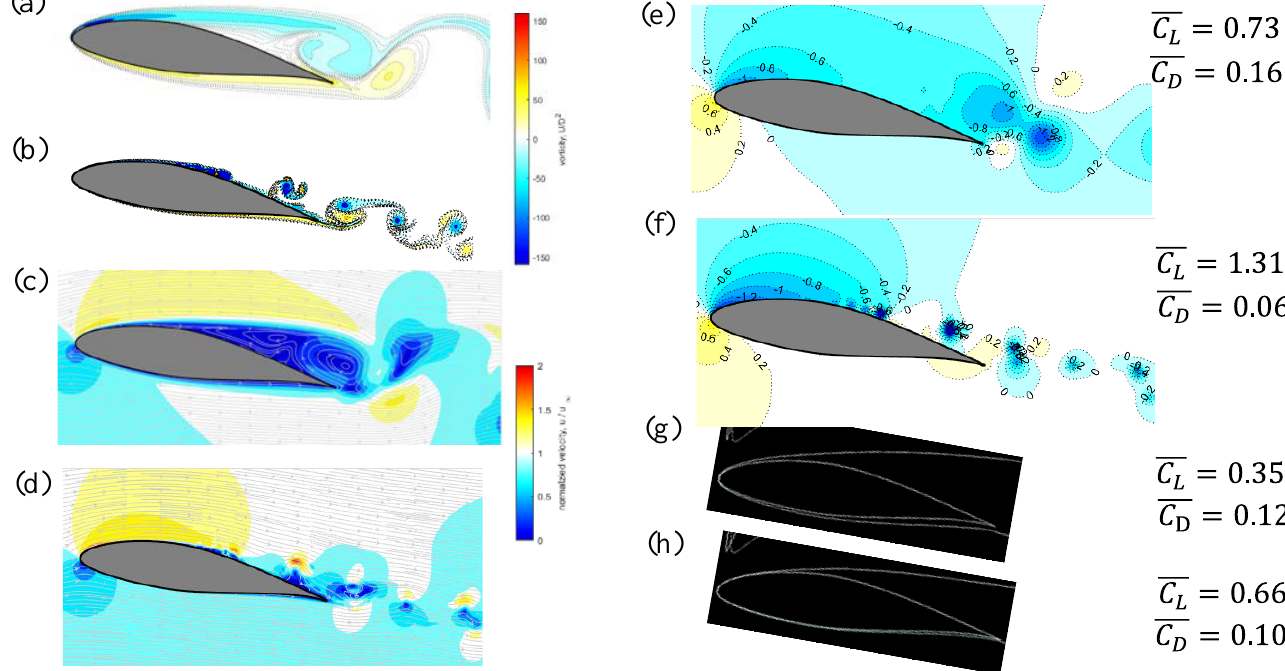
Figure 8. Instantaneous fields of NACA64 airfoil at α = 10 ◦ . Vorticity: ( a ) Re C = 4000 and ( b ) Re C = 60,000. Velocity: ( c ) Re C = 4000 and ( d ) Re C = 60,000. Pressure coefficients, Cp: ( e ) Re C = 4000 and ( f ) Re C = 60,000. Steady-state simulation of boundary layer streamlines by XFOIL: ( g ) Re C = 4000 and ( g ) Re C = 60,000. Note: ( a , c , e ) correspond to the first red star in Figure 4b ( Ut / C = 51.26) while ( b , d , f ) correspond to the first red star in Figure 4d ( Ut / C = 4.49). For ( e – h ), the associated mean force coefficients are attached on the right.